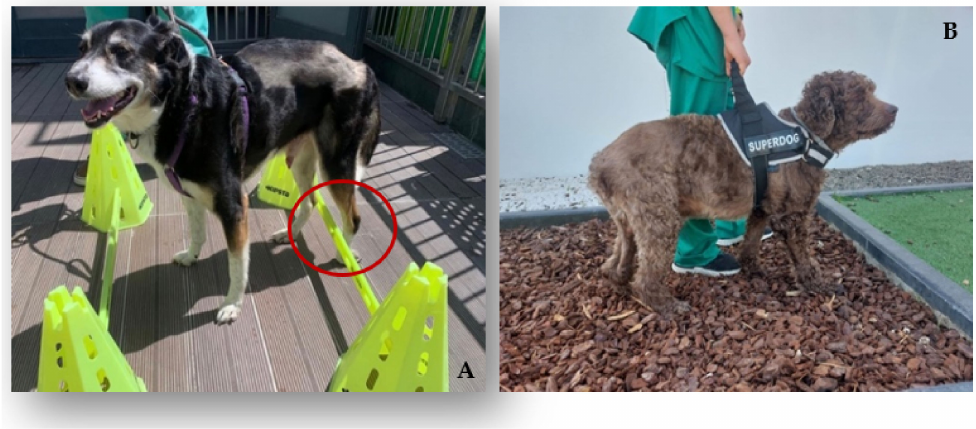
Figure 6. Kinesiotherapy exercises. ( A ) Obstacle rail; ( B ) gait stimulation on alternating floors; knuckling